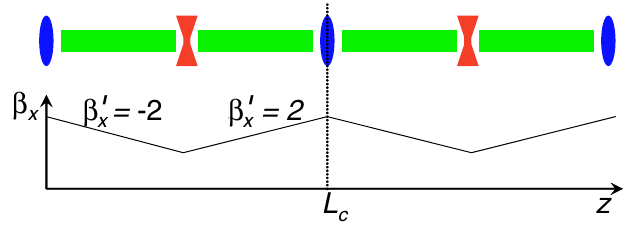
FIG. 5. (Color) Variation of the horizontal beta function along the distance of two FODO cells for a small phase advance per (cid:11) d(cid:11) =dz is close to the values (cid:13) 2 , but cell. Its derivative (cid:11) 0 x x from the average value (cid:2) (cid:11) is relatively small. the deviation of (cid:11) x is assumed to be much smaller than the The FODO cell length L c average beta function (cid:2) (cid:11)